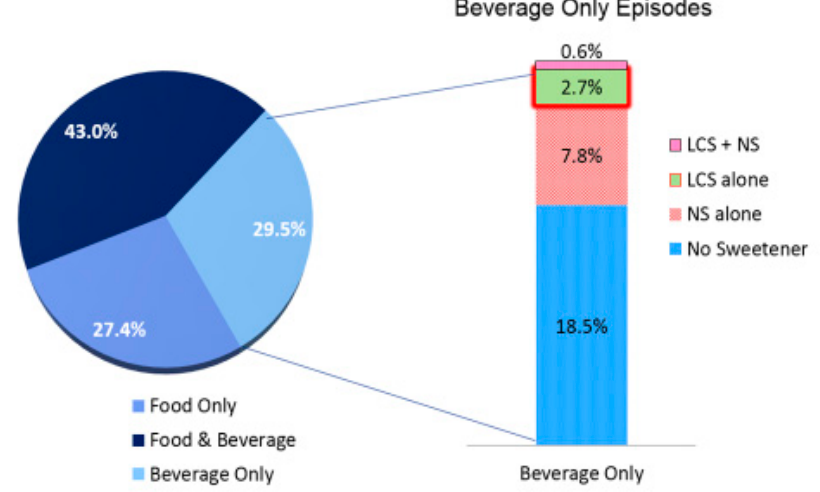
Figure 1. Prevalence of low-calorie sweetener (LCS) contained in eating episodes by type of eating episode and comparison of beverage only eating episodes by LCS and nutritive sweetener (NS) status (NHANES 2007–2016; eating episode n = 136,938; weighted N = 1,219,061,667). Focusing on LCS and NS containing foods, beverages or FBAs reported within episodes, 53.1%